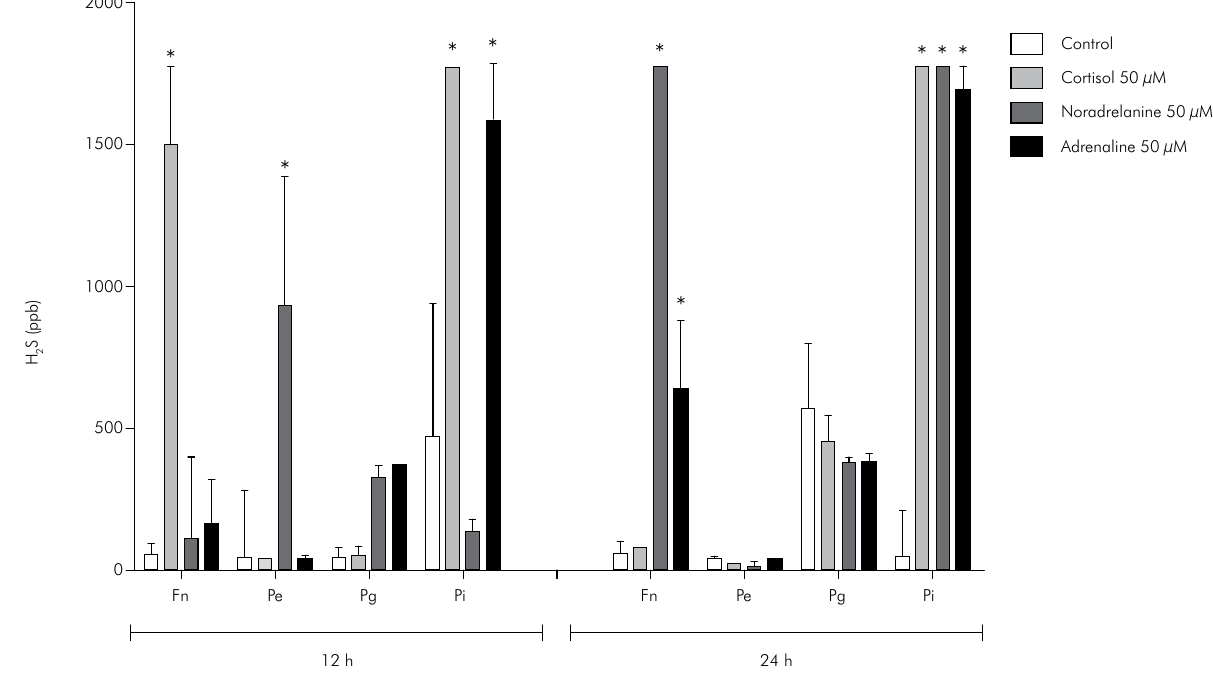
Figure 3. Median and interquartile deviation of H S concentrations (ppb) representing the VSCs production. Statistically significant 2 p values are shown (*) on the upper side of the columns ( p < 0.05, Kruskal Wallis, Dunn).